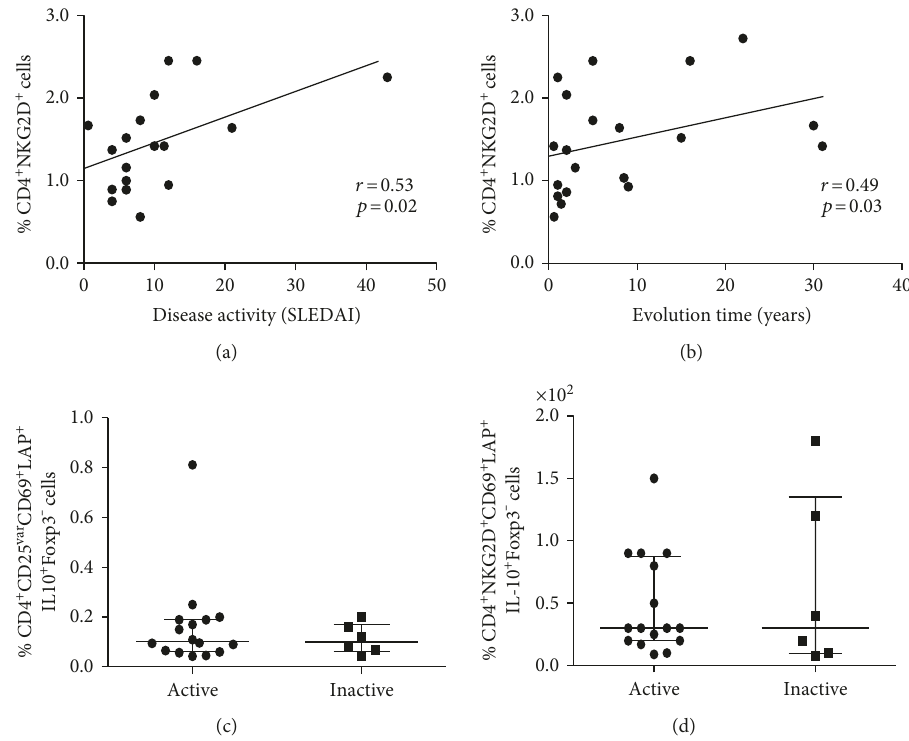
Figure 3: Levels of CD4 + CD69 + and CD4 + NKG2D + Treg cells and clinical features of SLE patients. The frequency of CD4 + CD69 + and CD4 + NKG2D + cells was determined in freshly isolated peripheral blood mononuclear cells from patients with systemic lupus erythematosus by fl ow cytometry, as indicated in Materials and Methods. (a, b) Correlation analysis between the levels of CD4 + NKG2D + cells and SLEDAI score or time of disease evolution in patients with SLE. r and p values (Spearman correlation test) are shown. (c, d) Levels of CD4 + CD69 + and CD4 + CD69 + NKG2D + Treg cells in the peripheral blood from SLE patients with (SLEDAI > 4.0) or without (SLEDAI ≤ 4.0) disease activity are